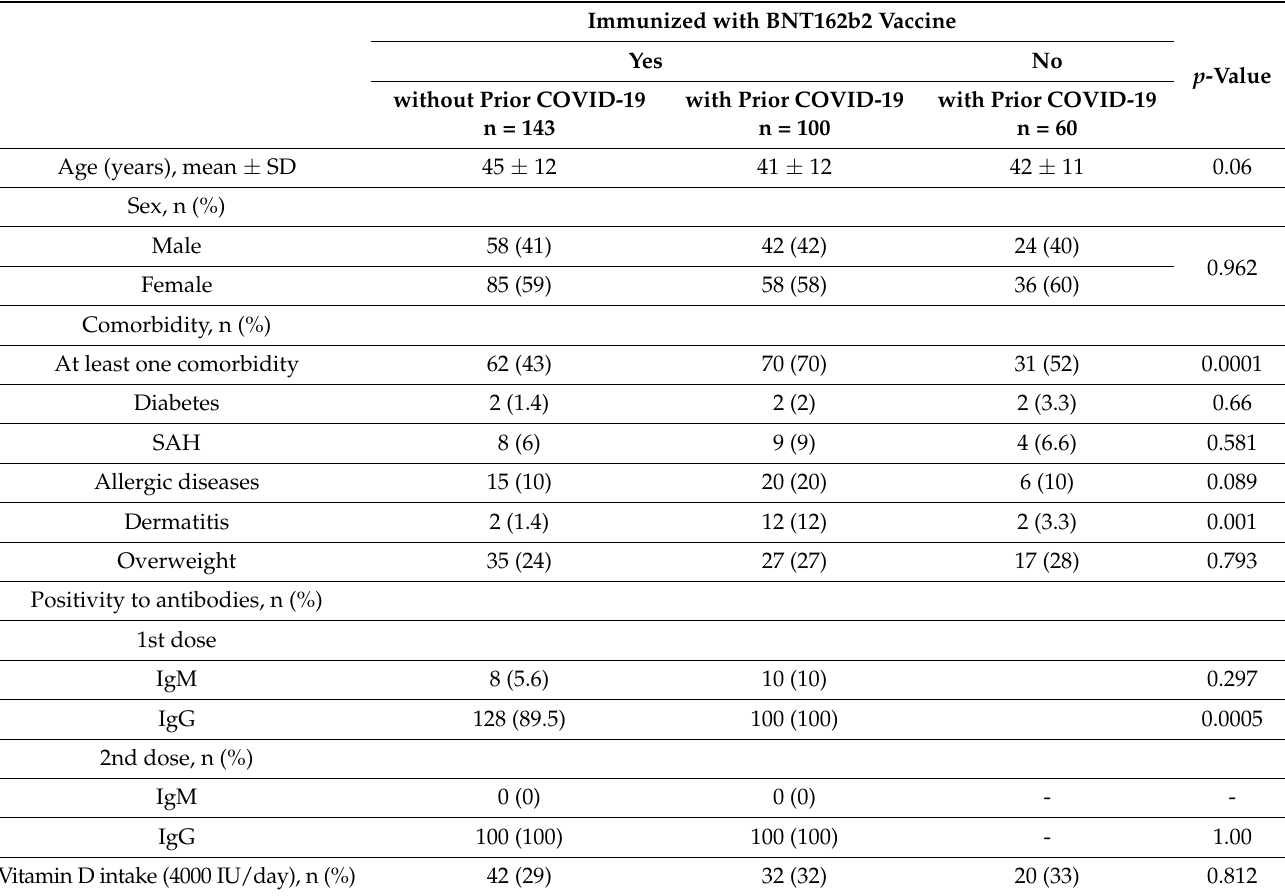
Table 1. Clinical and demographic characteristics of the study